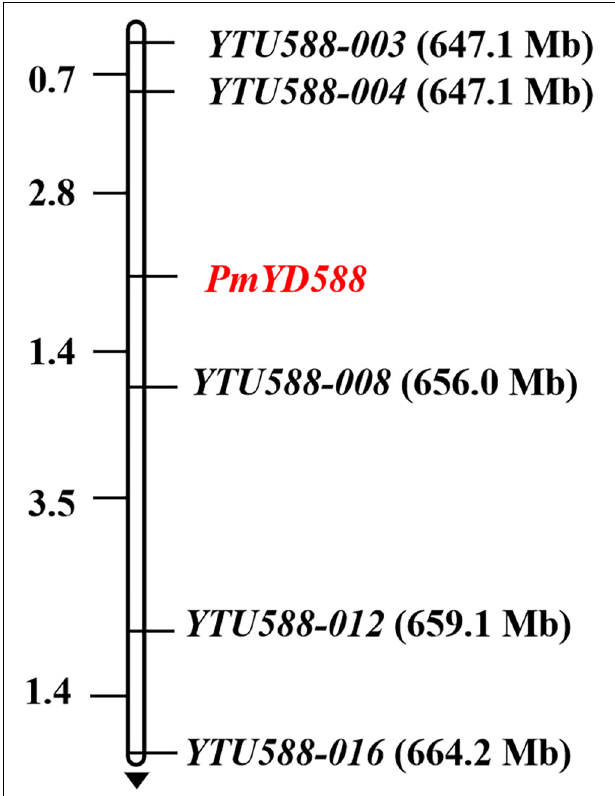
FIGURE 4 | Linkage map of PmYD588 using the F 2 : 3 families of YD588 × YN21. Genetic distances in cM are showed to the left. The black arrows point to the centromere.